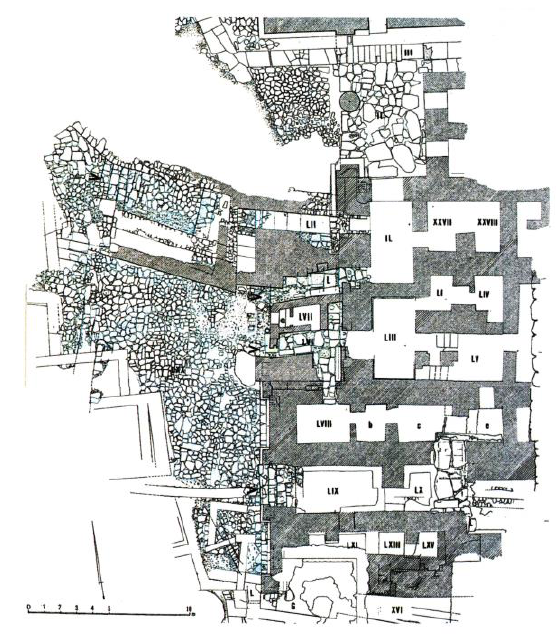
Figure 2. Phaistos. Plan of the South-West Quarter